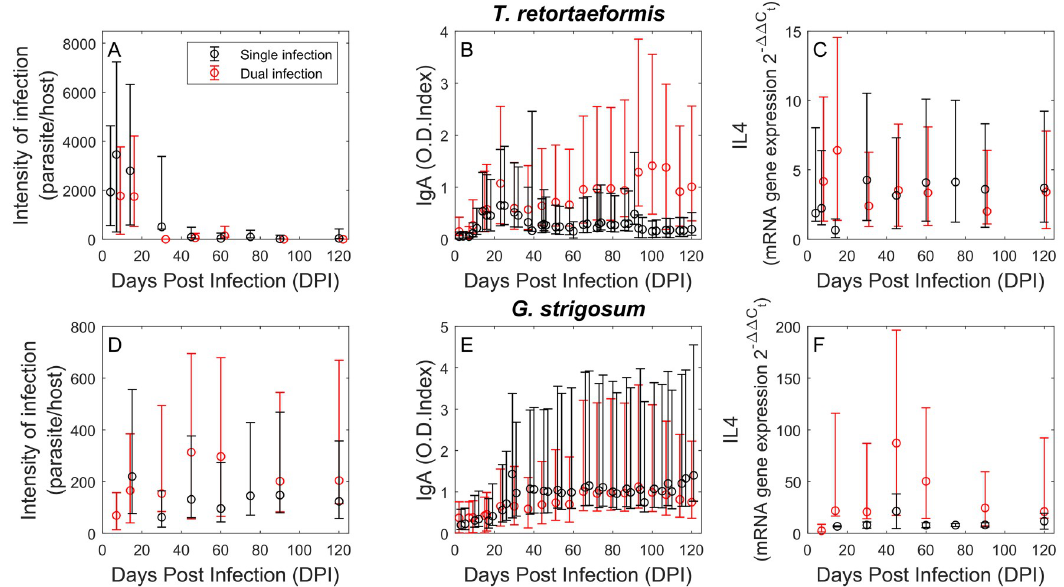
Fig 1. Experimental data of single and dual infections. Intensity of infection (A and D), specific IgA antibody response estimated using adult worms (B) or excretory-secretory (ES) products from adult worms as the source of antigen (E), and IL4 cytokine gene expression (C and F) during single (black) and dual (red) infections of T. retortaeformis (A-C) and G. strigosum (D-F). Geometric means and relative dispersions (calculated as product/ratio between the geometric mean and the geometric standard deviation) are